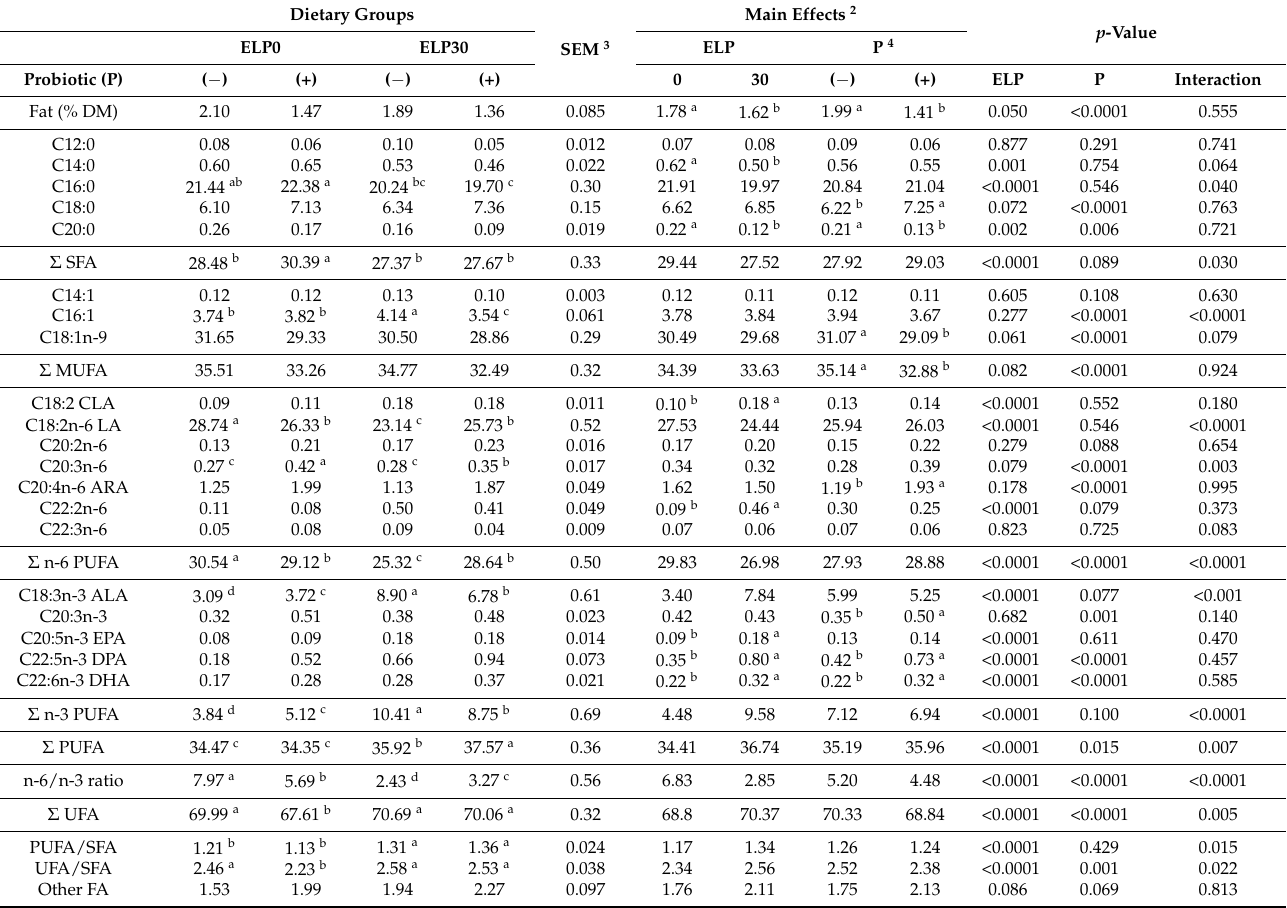
Table 5. Fatty acids profile (g/100 g FAME) 1 in breast